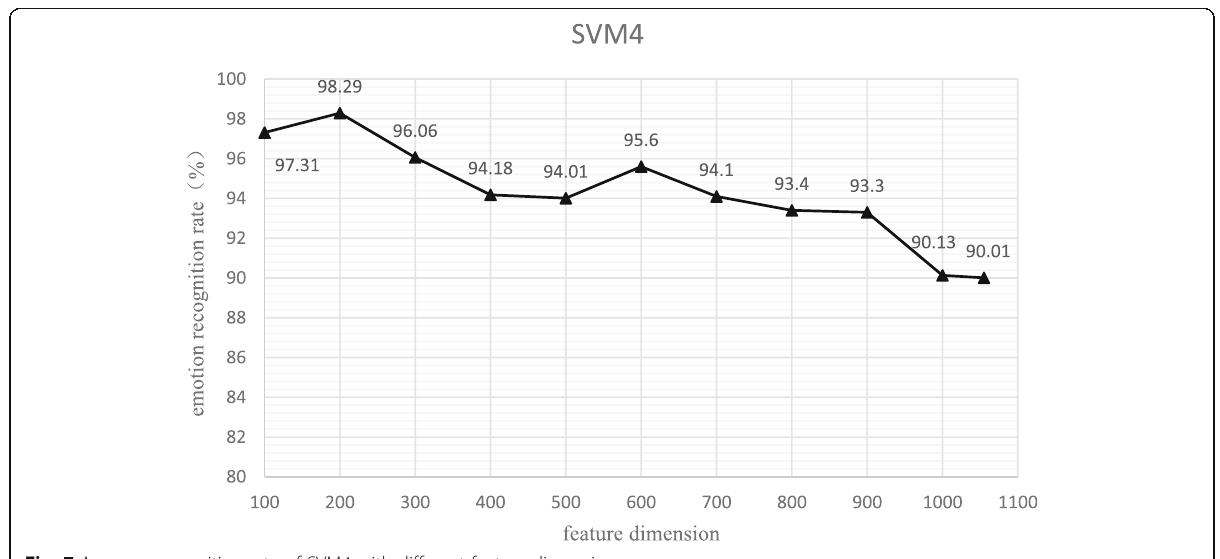
Fig. 7 Average recognition rate of SVM4 with different feature dimensions